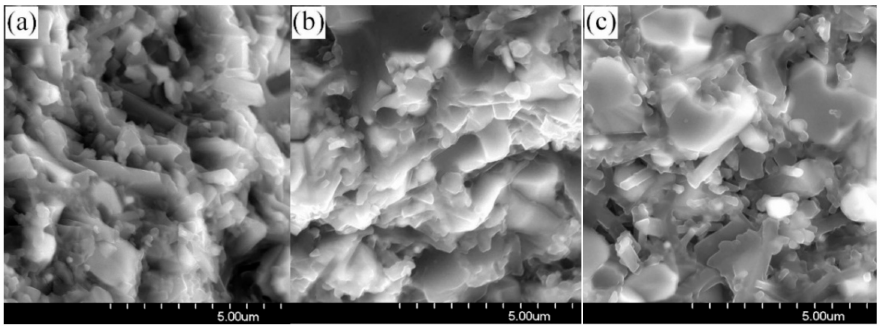
Figure 7. SEM microstructure of the fracture surfaces of Si 3 N 4 –MoSi 2 composites of sample ( a ) Si 3 N 4 -30 wt % MoSi 2 ; ( b ) Si 3 N 4 -45 wt % MoSi 2 ; ( c ) Si 3 N 4 -60 wt % MoSi 2